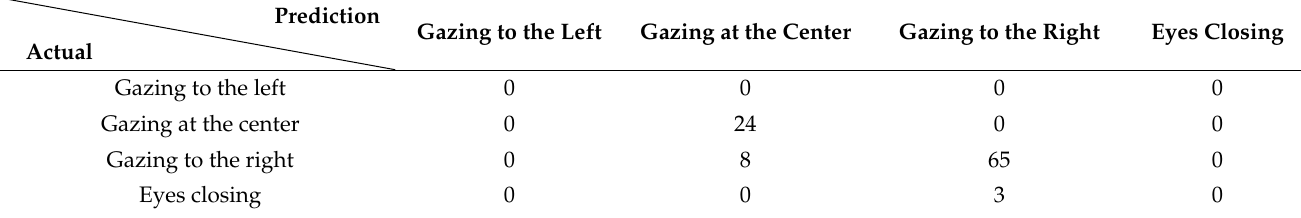
Table 5. Confusion matrix of the eye gazing recognition results of the elderly